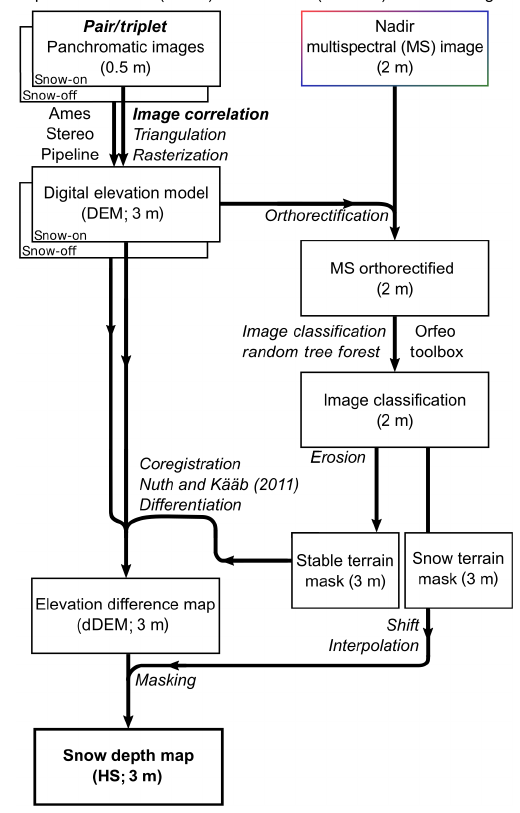
Figure 2. Workflow for the processing of the panchromatic and multispectral Pléiades images. Intermediate products are in the boxes, while the processing steps are in italics between the boxes. Text in bold italic characters indicates steps for which we tested different